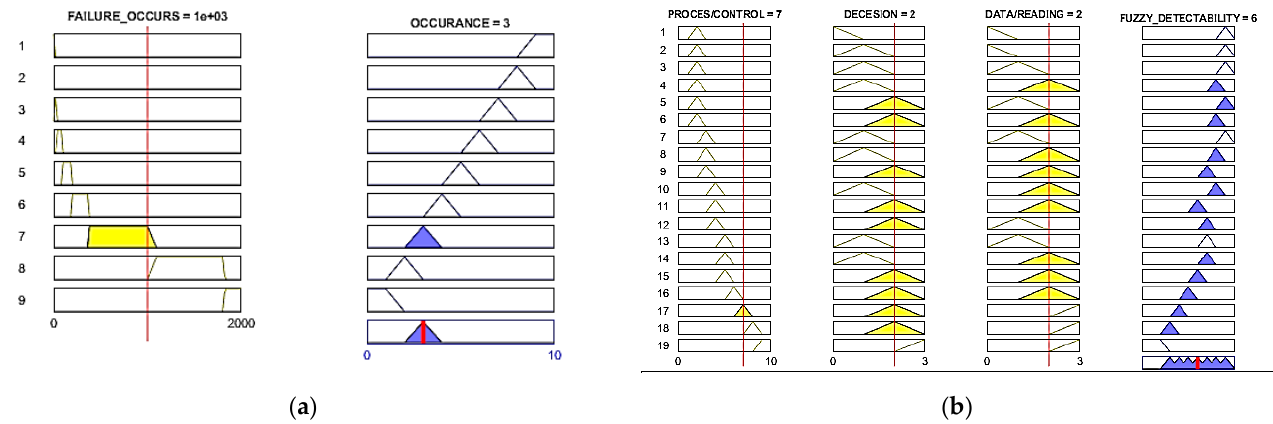
Figure 5. A part of the rule viewer used for modeling, Inference Diagram: ( a ) Occurrence rule plot; ( b ) Detectability rule plot.